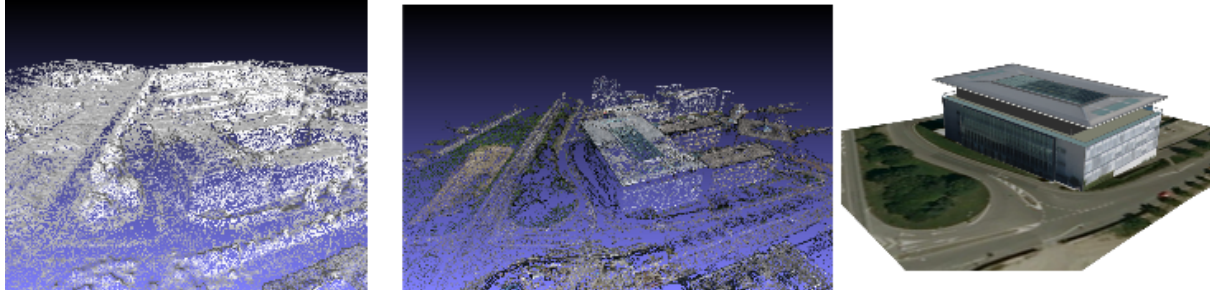
Figure 3: EPFL BC building: bundle block adjustment mesh, colorized dense matching 3D points, geolocalized refined textured model is facing the most a selected surfaces in order to minimize distor- tions, followed by a projection involving a homography from the image to the